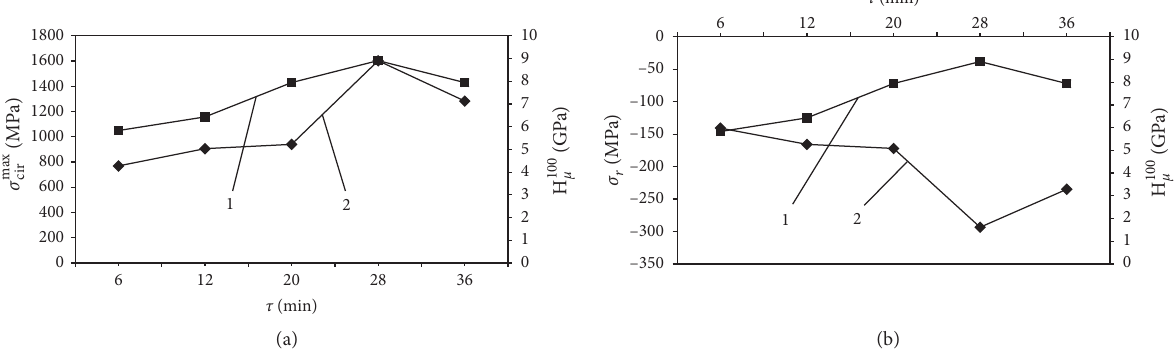
Figure 7: Dependence of the microhardness (1) and the magnitude and sign of the residual stresses (2) in the hardened layer after explosive treatment on the processing time with the weight of the hardened tool 4.5 kg: (a) circular compressive stresses, σ max s stresses, σ r .